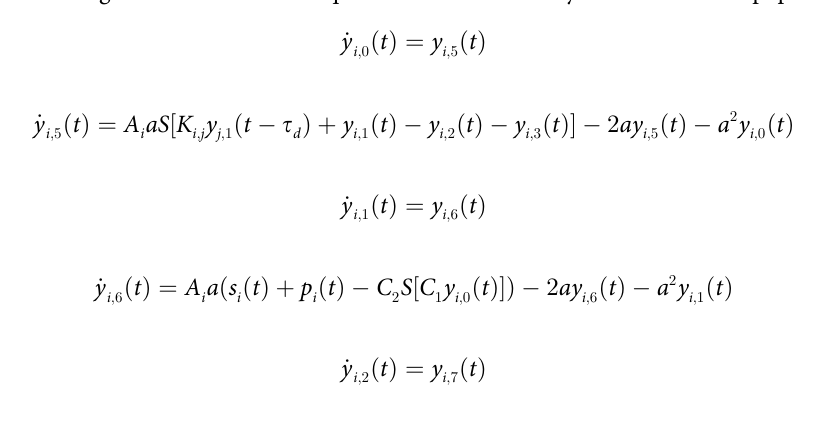
Fig 1. Modified neural mass model. (a) Representation of each coupled neuronal population and corresponding subpopulations. Excitatory interneurons are implicitly represented as the self-feedback loop from main pyramidal cells (EXC i to itself). Each model settings consists of either (I) unilateral ( s probing stimulation ( s 1 and s 2 ), while slowly changing one parameter towards ictal activity–A 1 , B 1 or K.